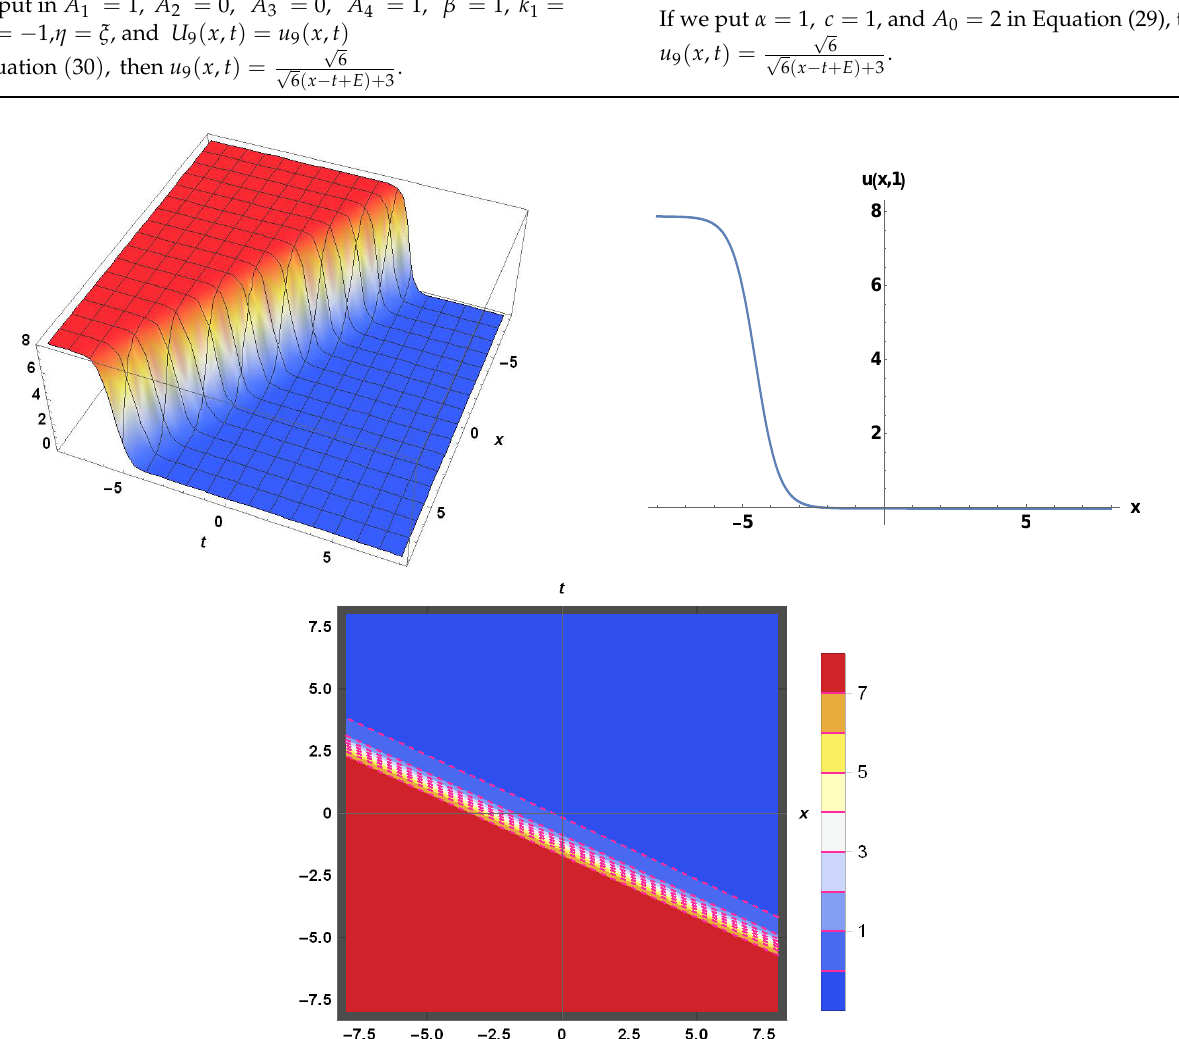
Figure 1. The solitary wave view of the 3D, 2D, and contour plots of U 1 ( x , t ).